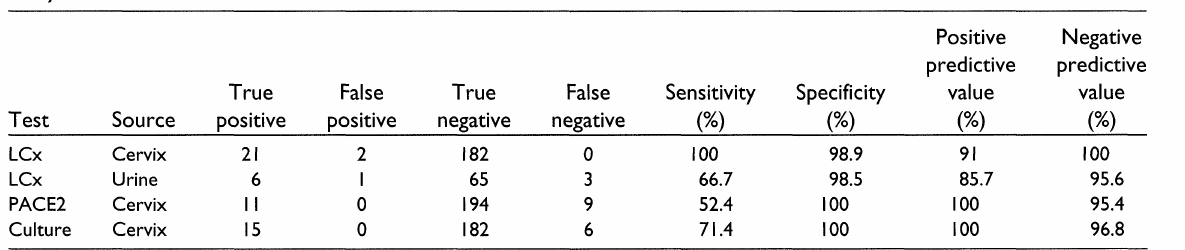
TABLE I. Performance of LCx, PACE2, and culture for detection of Chlamydia trachomatis after discrepant